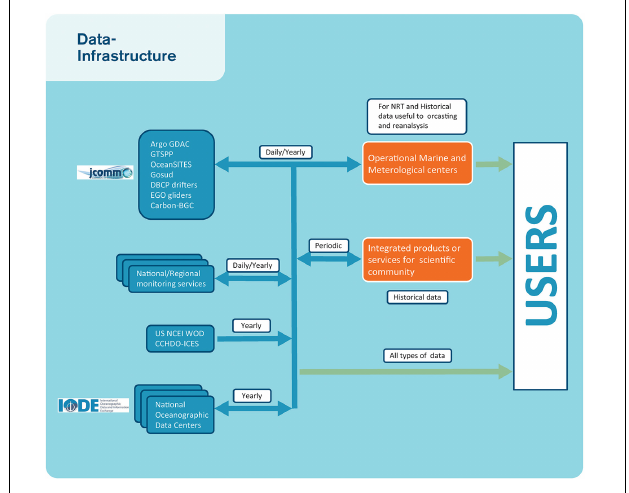
FIGURE 2 | An example of interfaces with observing networks, monitoring centers, and Nations Oceanographic data centers needed to build user products and how the integrators can collaborate together exchanging data and products using FAIR